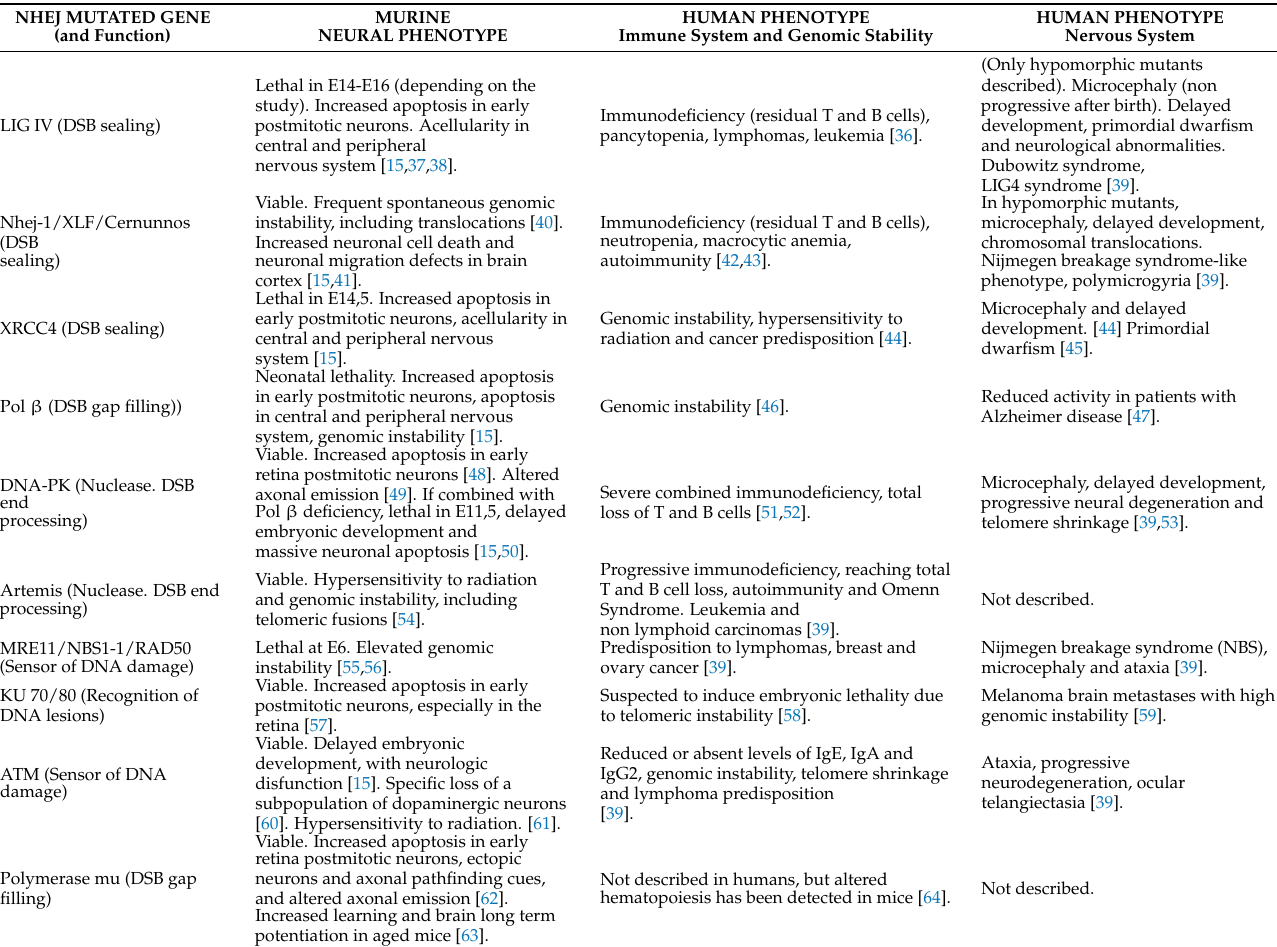
Table 1. Impact on nervous and immune system of defective proteins implicated in NHEJ. The table summarizes the phenotypes observed in human and murine mutants on proteins involved in NHEJ DSB